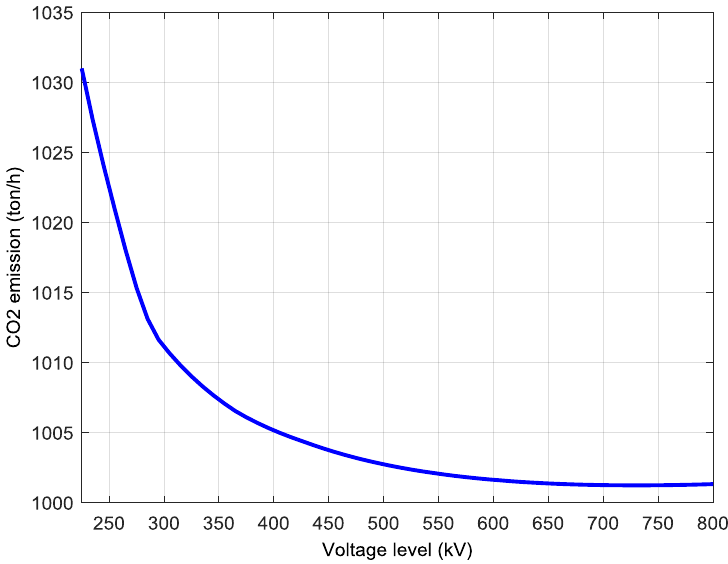
Figure 5. Variation of CO 2 emission in accordance with the voltage increasing.